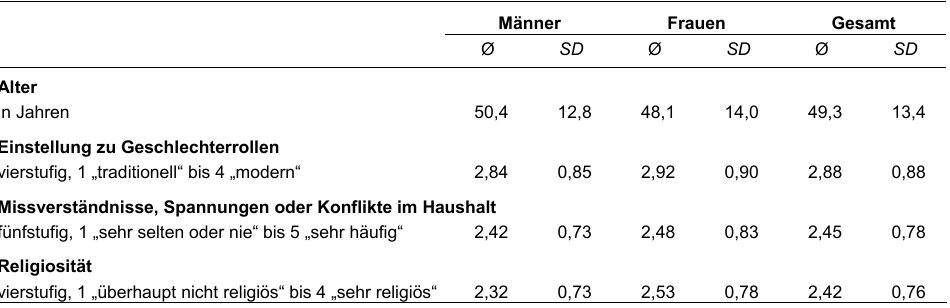
Tabelle 5: Beschreibung der Merkmale des Analysesamples (Individualebene